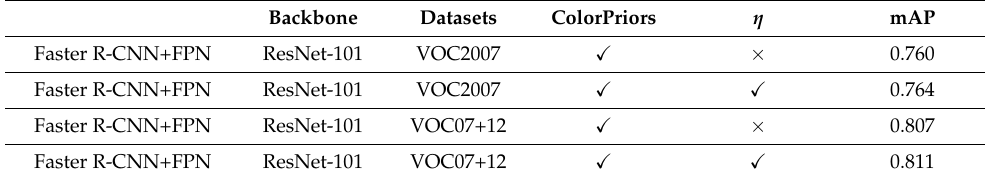
Table 4. Performance comparison of object detection algorithms with/without forgetting factor.